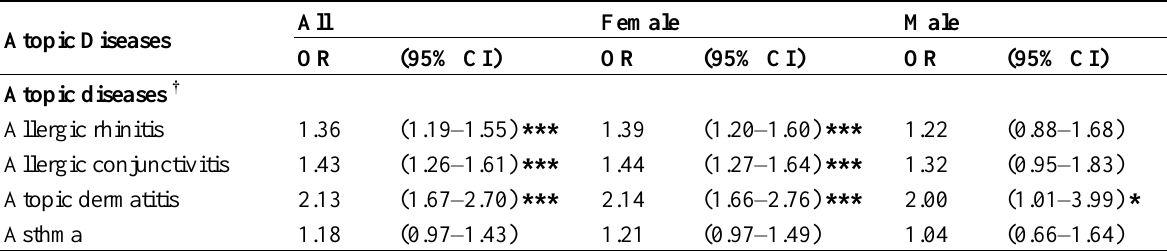
Table 2. Logistic regression estimated odds ratio of SLE associated with atopic diseases by